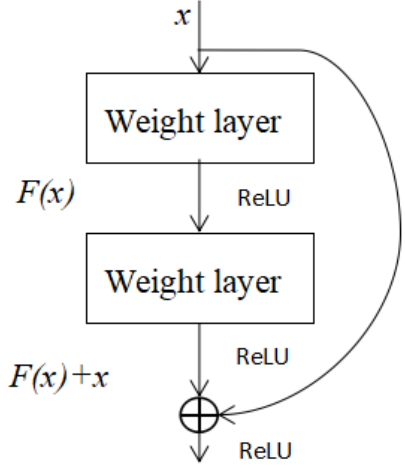
Figure 7. Residual learning: a building block.